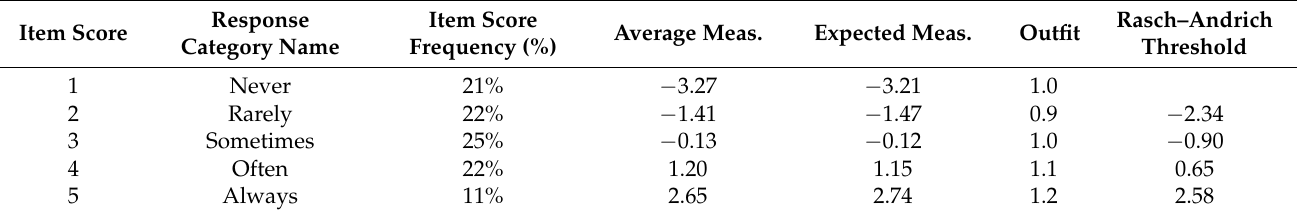
Table 5. Response category statistics and Rasch–Andrich